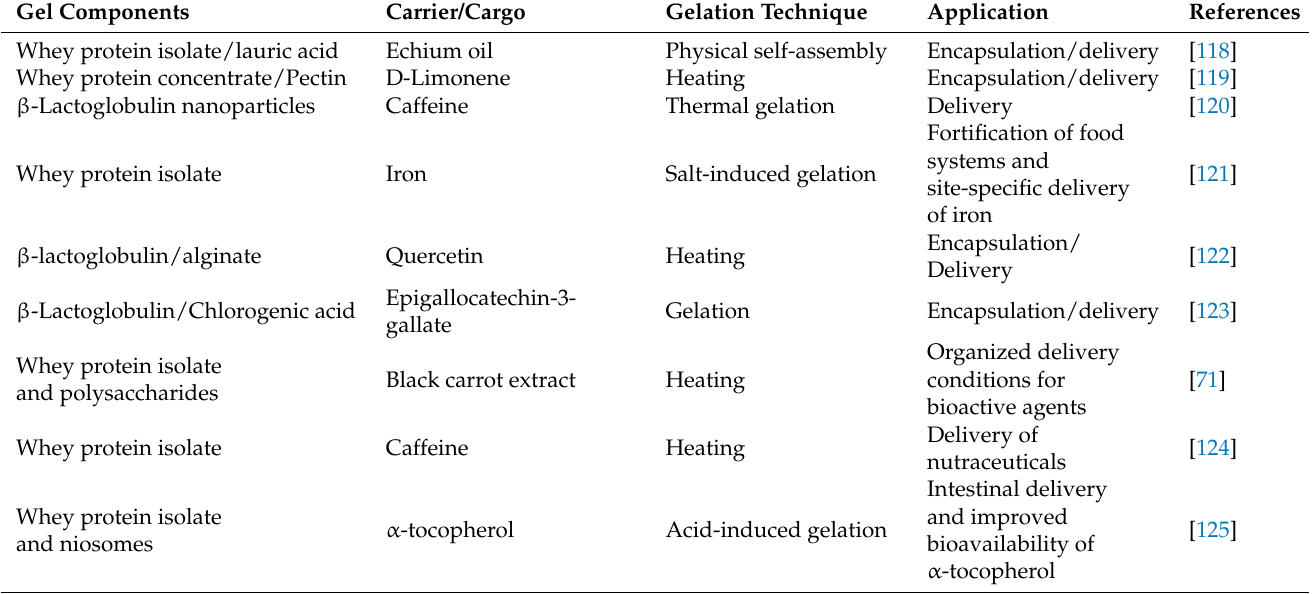
Table 1. Applications of whey-protein-based nanohydrogels in the food